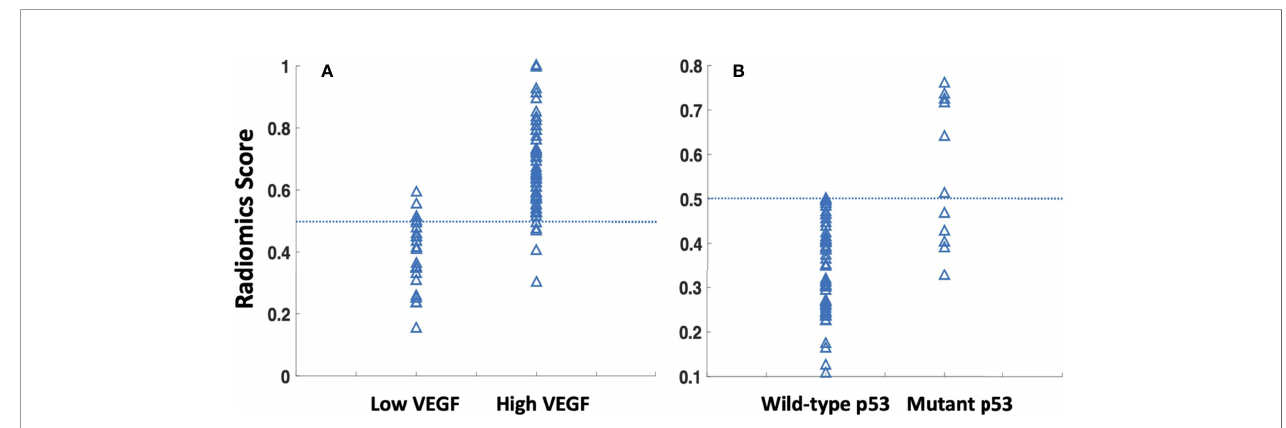
FIGURE 5 | The radiomics scores were calculated using the developed radiomics models for all cases, classi fi ed using 0.5 as the threshold. (A) For prediction of low vs. high VEGF groups, showing 27 true low VEGF, 4 false low VEGF, 44 true high VEGF, and 5 false high VEGF. (B) For wild-type vs. mutant p53 groups, showing 68 true WT-p53, 0 false WT-p53, 7 true mutant p53, and 5 false mutant